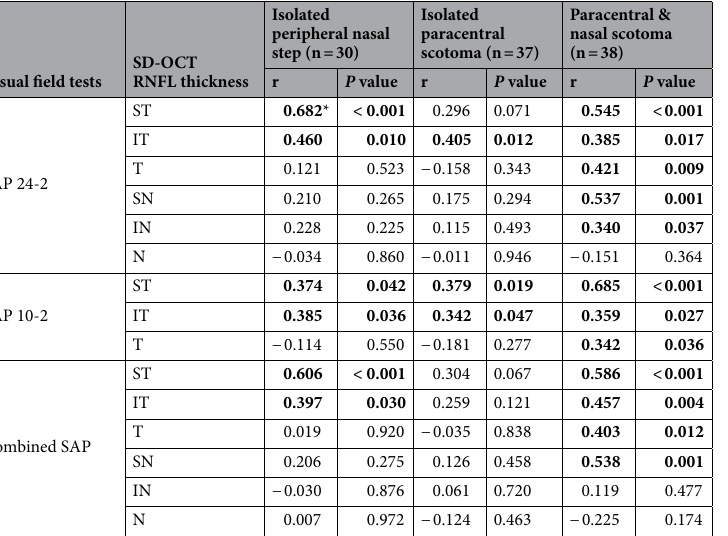
Table 3. Topographic structure–function relationship between regional visual field sensitivity measured with standard automated perimetry 24-2 or standard automated perimetry 10-2 or combined SAP and the corresponding peripapillary retinal nerve fiber layer (RNFL) thickness. Statistically significant values ( P < 0.05) are shown in bold. RNFL, retinal nerve fiber layer; SAP, standard automated perimetry; SD-OCT, spectral domain optical coherence tomography. r = Pearson’s correlation coefficient. *Statistically significant difference with P < 0.05 between SAP 24-2 and SAP 10-2. † Statistically significant difference with P < 0.05 between SAP 24-2 and combined SAP. ‡ Statistically significant difference with P < 0.05 between SAP 10-2 and combined